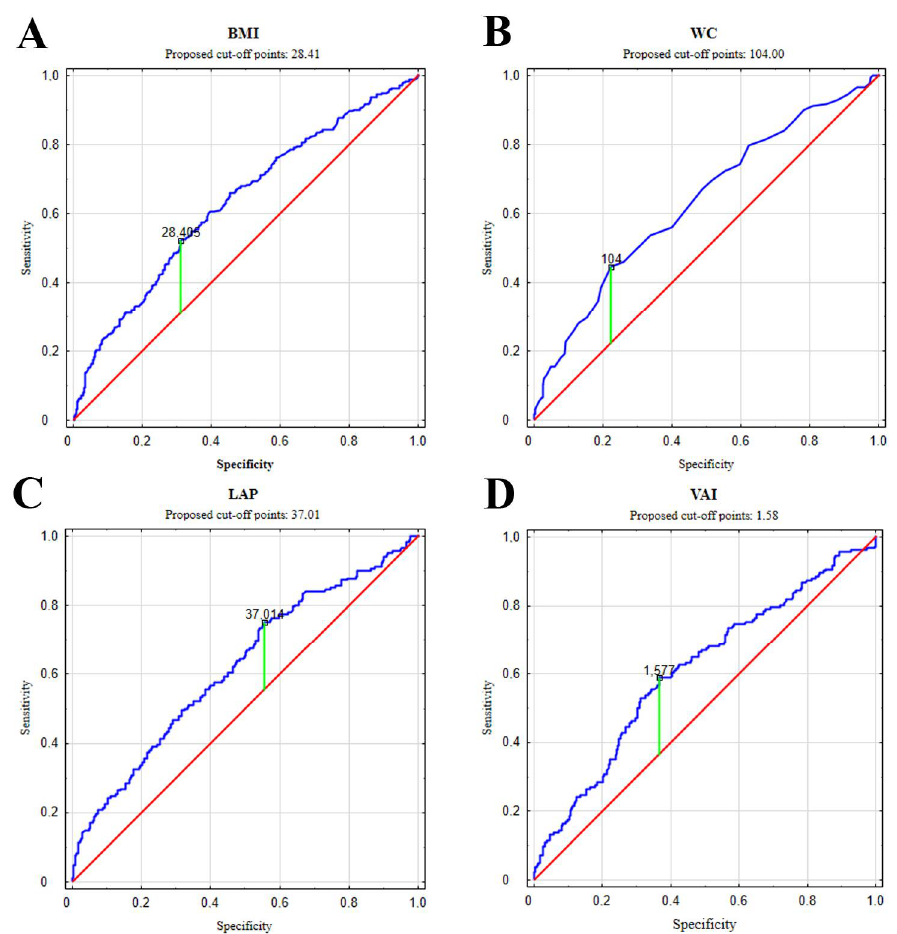
Figure 1. ROC curves. Cut-off points for the selected indicators of adiposity against testosterone levels: blue lines—The ROC curves for the BMI (A), WC (B), LAP (C), VAI (D), red lines—reference line.